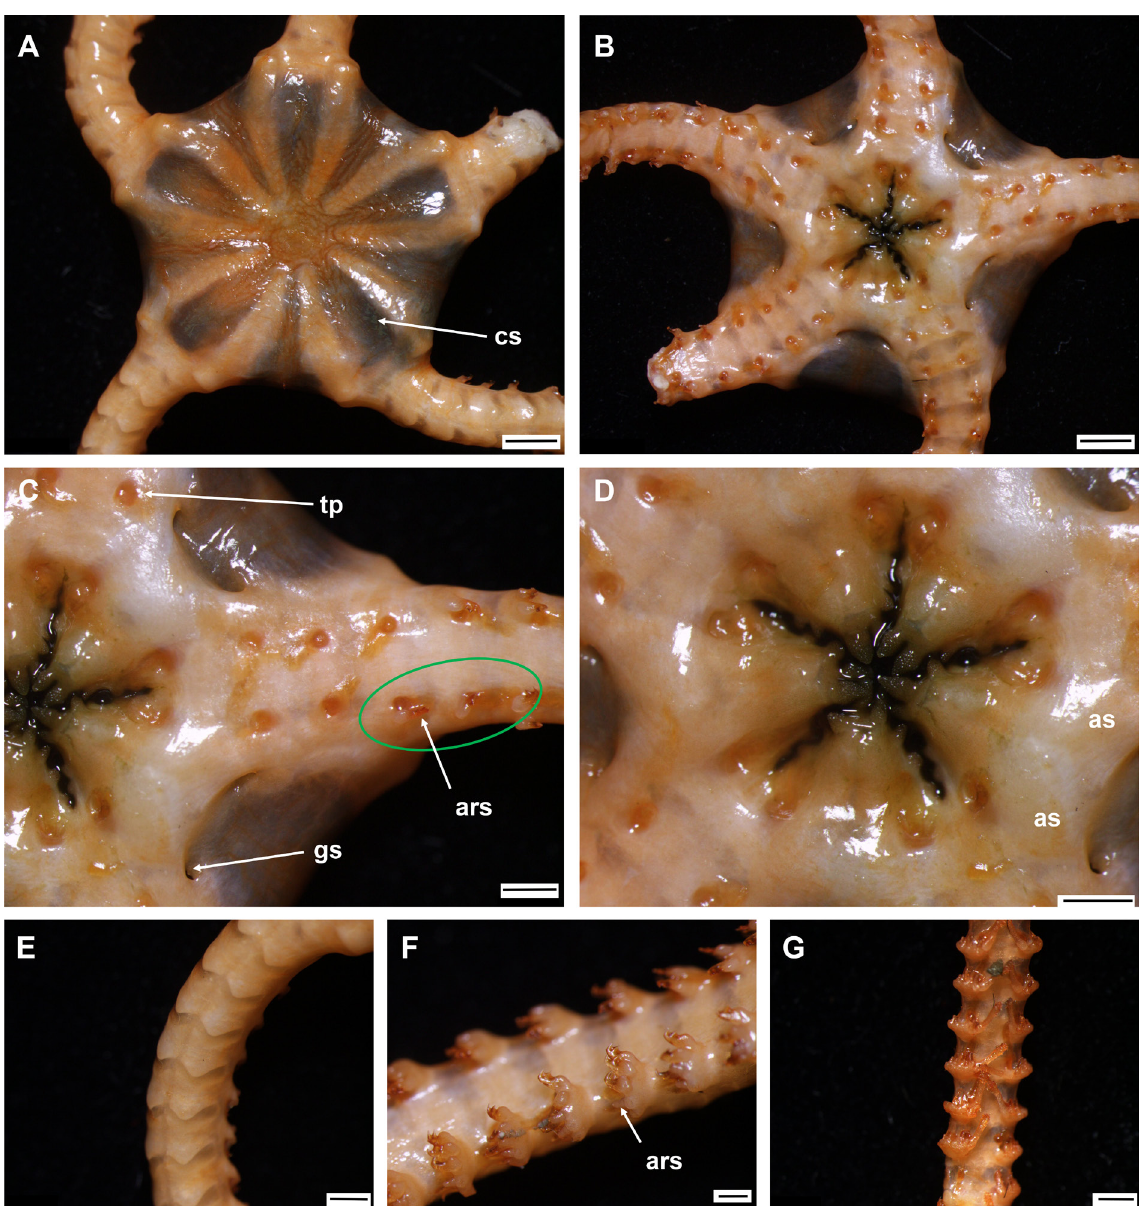
Fig. 4. Asteronyx luzonicus Döderlein, 1927 (IDSSE EEB-SW0003). A . Dorsal disc. B . Ventral disc. C . Ventral arm base (start of first arm spine highlighted). D . Oral frame. E . Dorsal arm. F–G . Ventral arm (proximal and distal region). Abbreviations: ars = arm spine; as = adoral shield; cs = calcified scales; gs = genital slit; tp = tentacle pore. Scale bars: A–B = 2 mm; C–E, G = 1 mm; F = 500